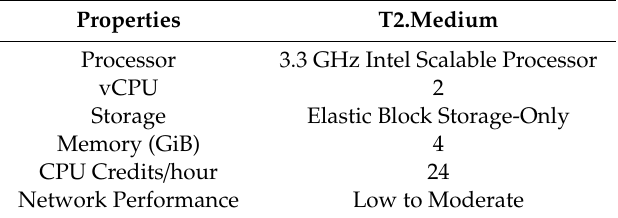
Table 2. Specifications of the t2.medium for